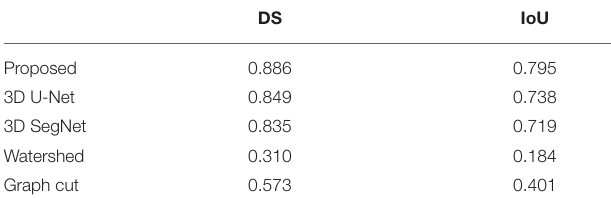
TABLE 2 | Average processing time per case for the proposed model, 3D U-Net, and 3D SegNet.